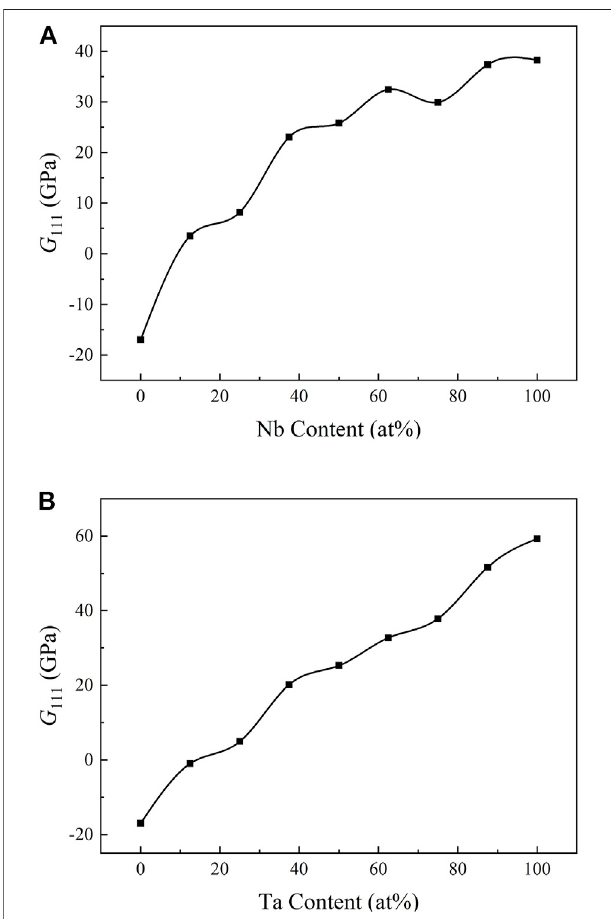
FIGURE 9 | Shear moduli of (A) β -TiNb and (B) β -TiTa alloys.